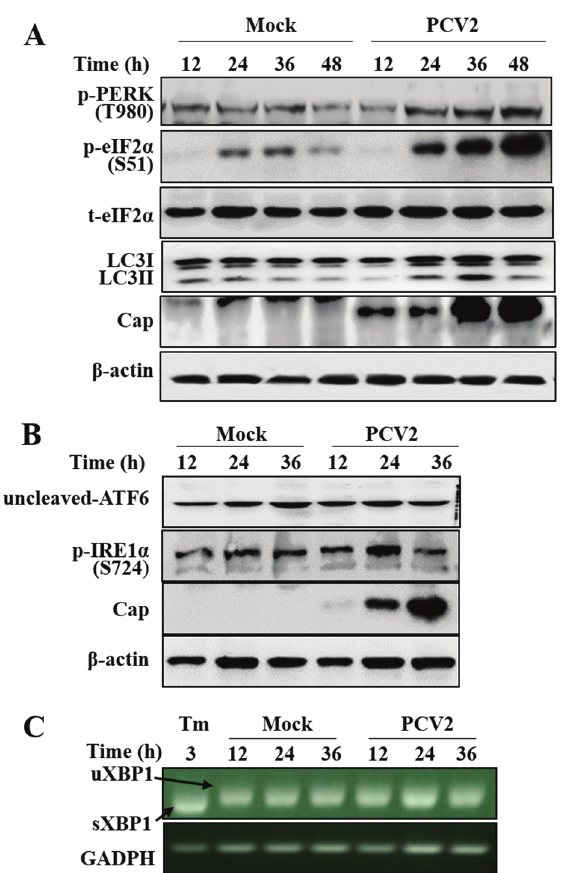
Figure 1. Porcine circovirus 2 infection induced unfolded protein response and autophagy in PK-15 cells. PK-15 cells were infected with PCV2 (MOI = 1) or mock-infected for indicated time points (A, B and C). ( A ) Western blotting of phosphorylated forms of PERK (p-PERK) and eIF2 α (p-eIF2 α ), total eIF2 α , autophagy marker LC3-II and PCV2 capsid expression; ( B ) Western blotting of ATF6 and phosphorylated IRE1 α (p-IRE1 α ); ( C ) PK-15 cells were either treated with tunicamycin (Tm) for 3 h or infected with PCV2 (MOI = 1) for indicated time points. Total RNA was extracted and analyzed for splicing of XBP1 (sXBP1 for the spliced, or uXBP1 for the unspliced) visualized on 2% agarose gel after reverse transcription PCR using with XBP1-specific and GAPDH-specific primers. Tunicamycin was used as a positive control for induction of XBP1 splicing (sXBP1) and GAPDH levels as loading control.